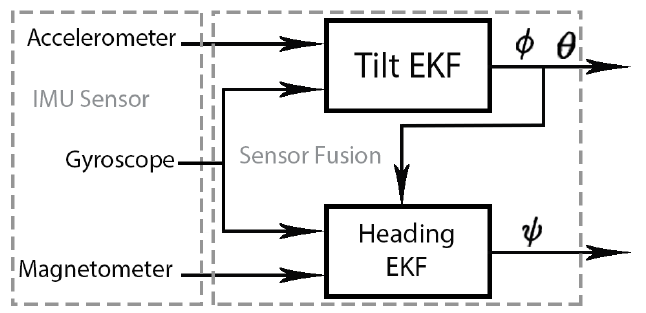
Figure 3. Scheme of EKF used in the orientation